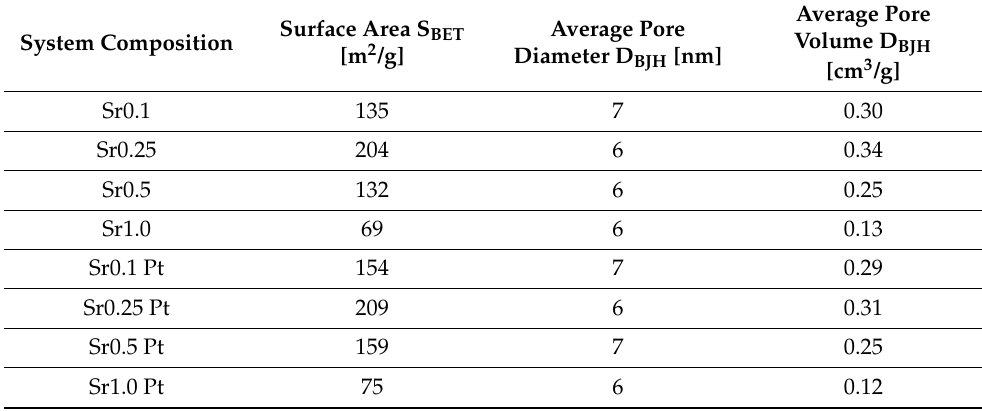
Table 1. Textural properties of Sr systems.